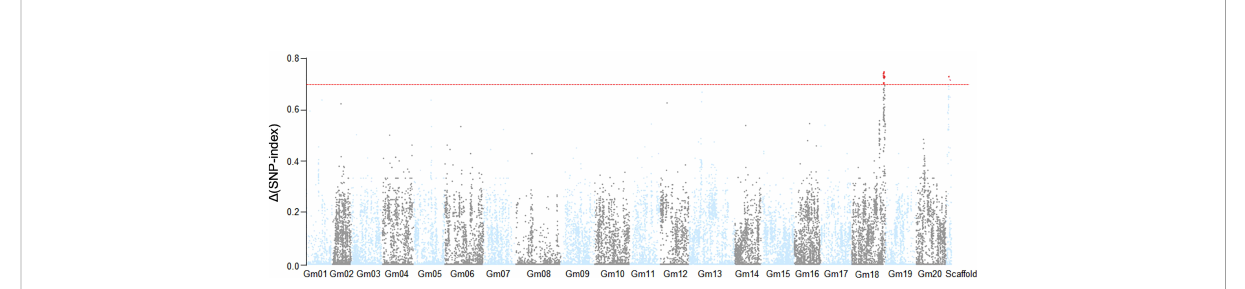
FIGURE 2 Identi fi cation of fl owering time loci through SNP-index analysis. The result of SNP-index association analysis. The red lines show the threshold of D (SNP- index), which is represented by the top 5% of the permutation test. A larger value of D (SNP- index) indicates a stronger level of association. Under a threshold of 0.6964, two SNP markers on Gm18 and scaffold_32 signi fi cantly associated with the fl owering time trait.